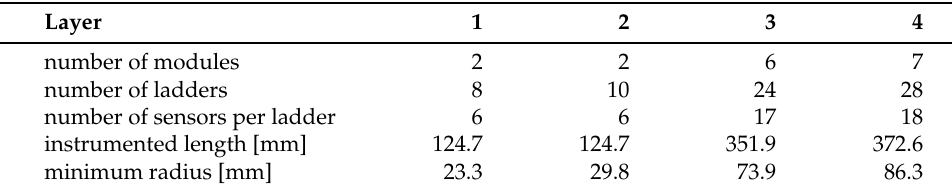
Figure 5. ( a ) Lateral layout of the tracker’s central station. ( b ) CAD drawing of the Mu3e tracker’s mechanical components. The violet stripes are parts of the electrical connections, which are integrated in the module mechanics [1]. Table 1. Pixel tracker geometry parameters of the central barrel. The radius is defined as the nearest distance of sensor w/o polyimide support to the symmetry axis (beam line). From